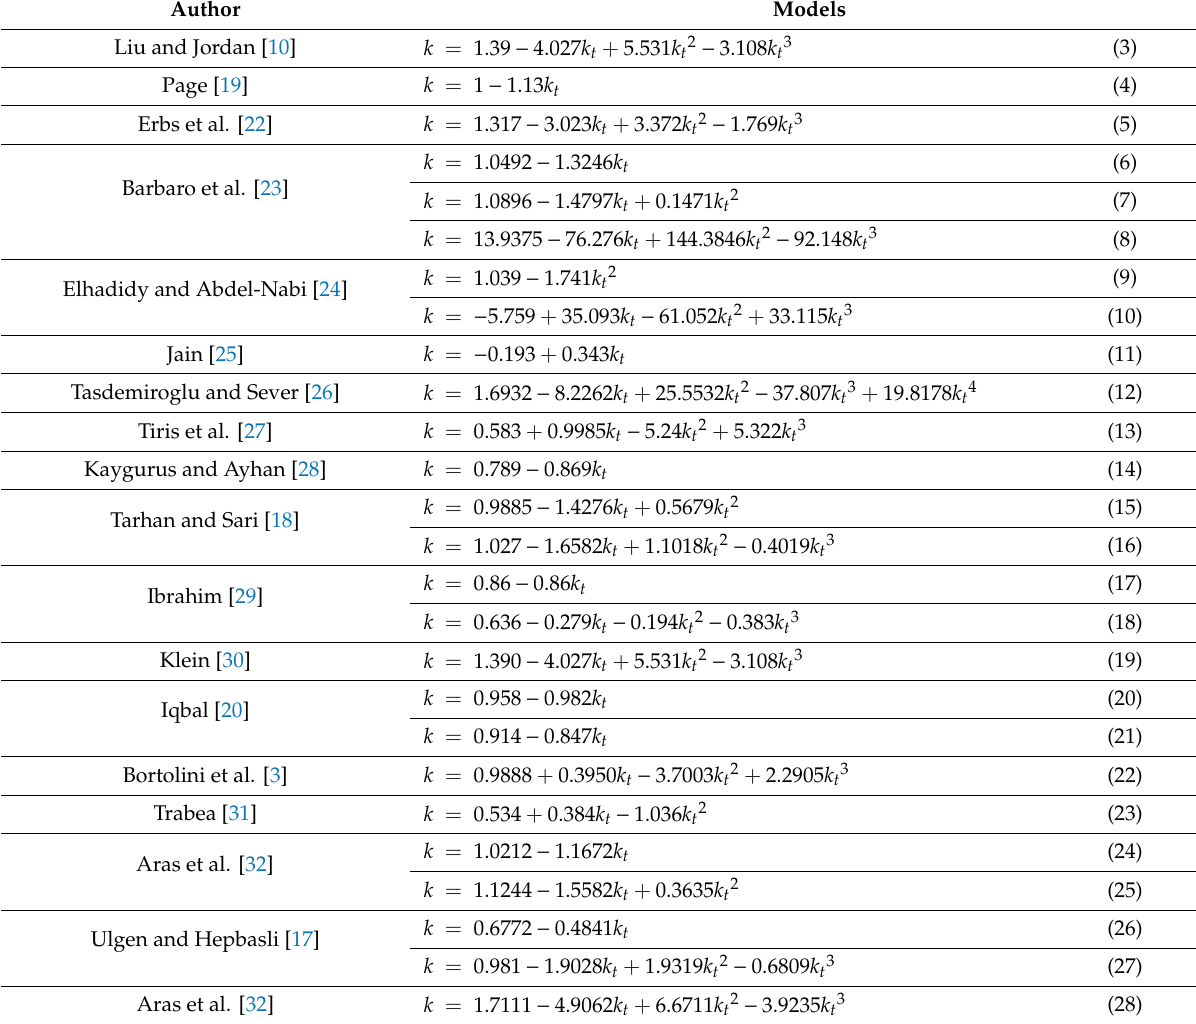
Table 1. Monthly-Average Di ff use Irradiation